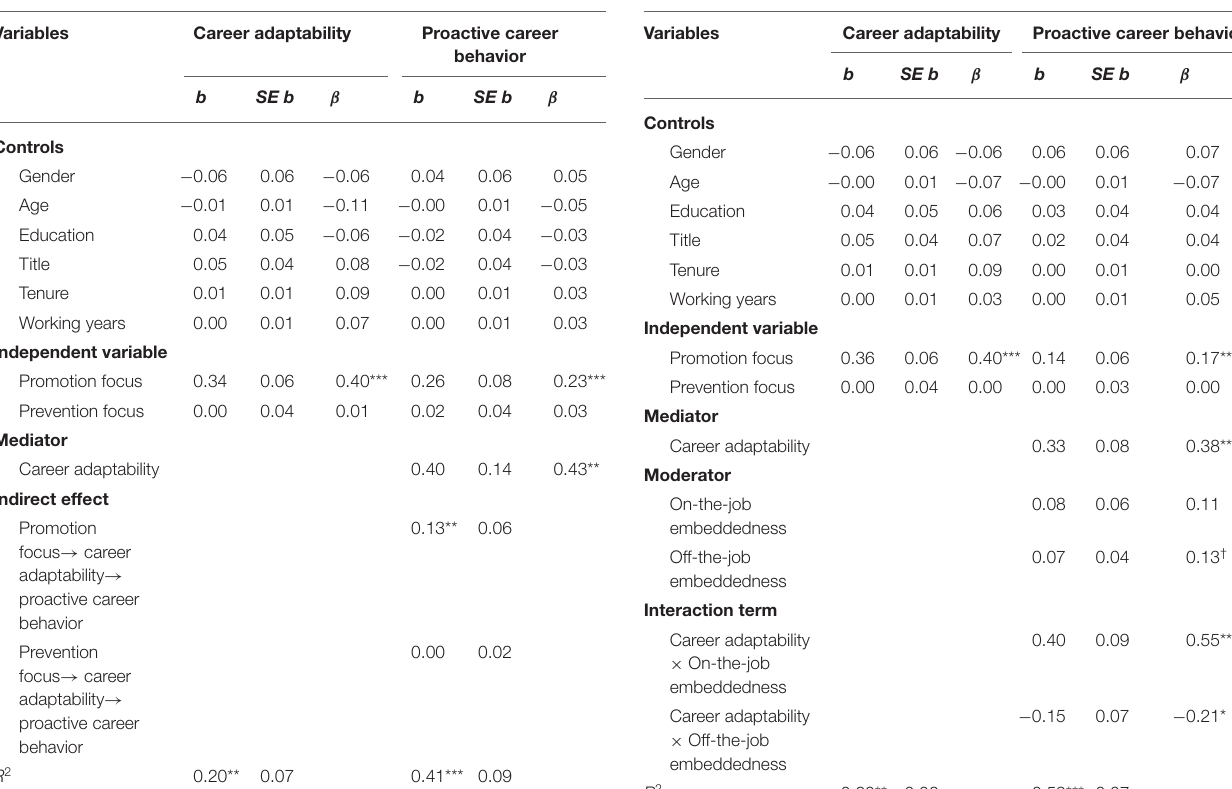
TABLE 3 | Summary of Hypotheses 1–4 results. TABLE 4 | Summary of Hypotheses 5 results.